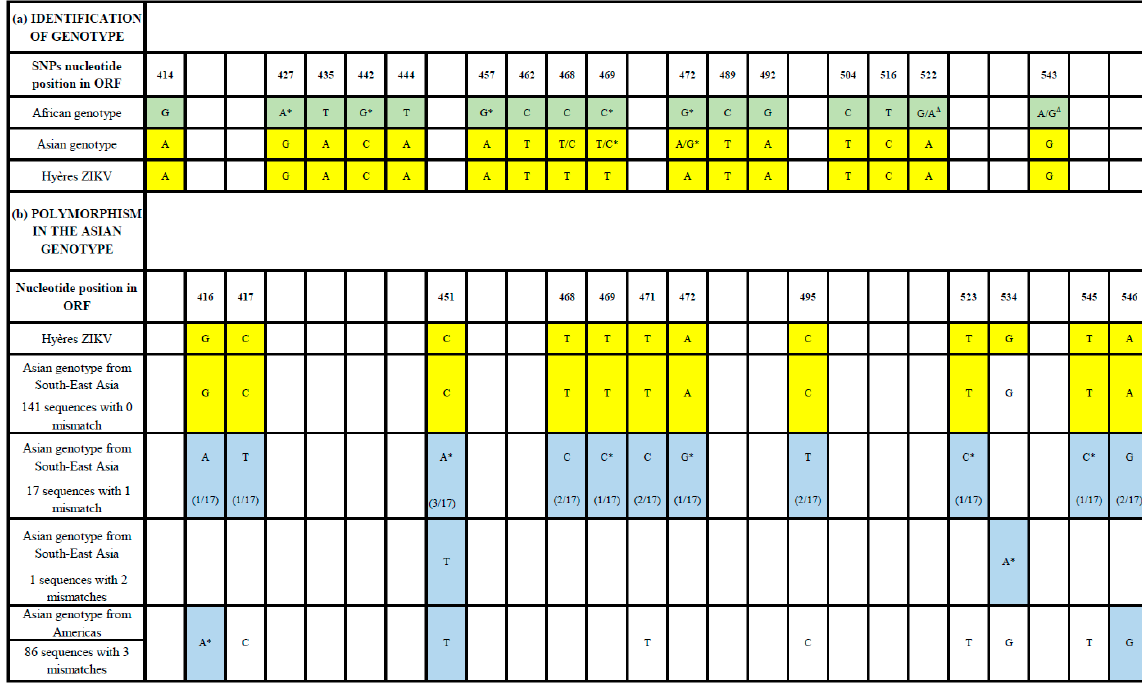
Figure 1. Identification of the genotype ( a ) and analysis of polymorphism in the Asian genotype ( b ). * Non-synonymous mutations. Δ Present only in sequence KY288905.